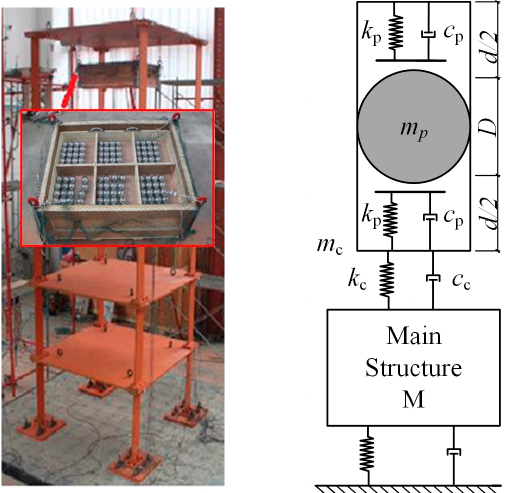
Figure 15. The test model and a simplified schematic of the system.